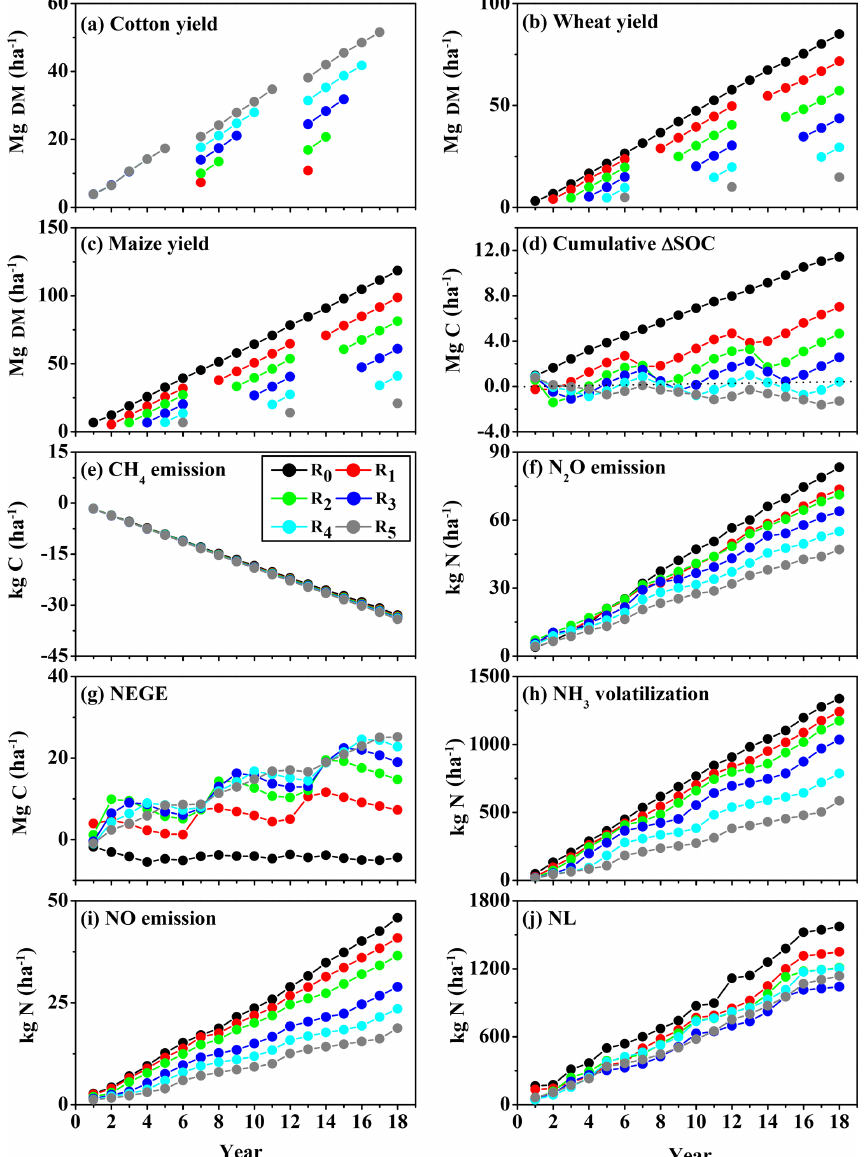
Figure 3. Simulated cumulative crop yields, changes in soil organic carbon ( (cid:49) SOC), methane (CH 4 ), nitrous oxide (N 2 O) releases, net ecosystem aggregate greenhouse gas emission (NEGE), ammonia (NH 3 ) volatilization, nitric oxide (NO) emission, and nitrate leaching (NL) of individual rotation patterns (with a 6-year rotation cycle) over an 18-year period. R 0 , R 1 , ..., R 5 represent rotation patterns with the cotton cultivated consecutively for 0, 1, ..., 5 year(s), respectively, within each 6-year rotation cycle. The legend in (e) applies to all panels. The simulations resulted from the modified model driven by the currently applied field management practices (i.e., the baseline field management scenario) and the observed means of input soil